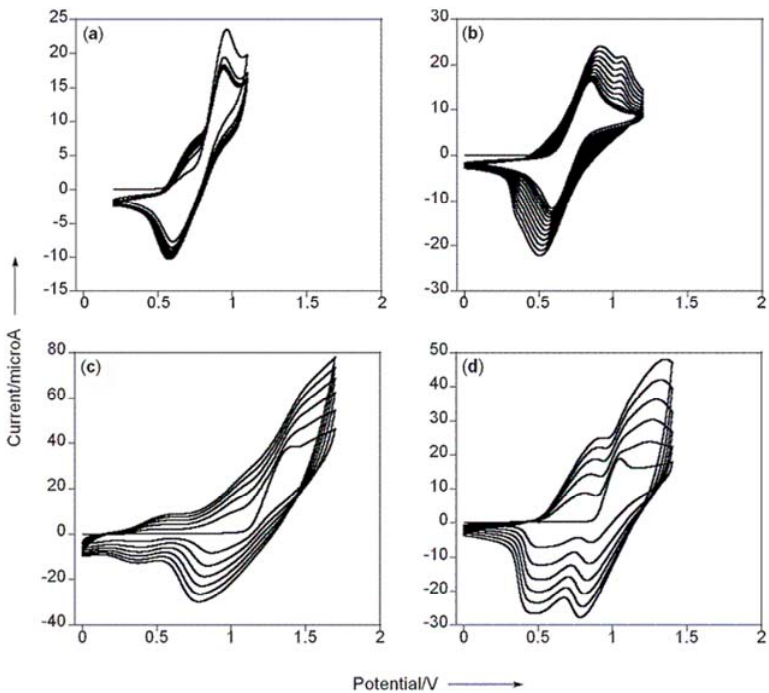
Figure 2. Polymer growth profiles plotted relative to Ag/Ag + for (a) MT, (b) MBT ,